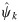
Algorithm to compute spike-based grid scores ψ^k and orientations θk and their averages Ψ and Θ.